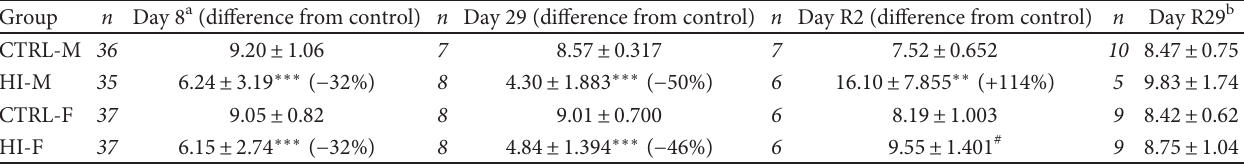
Table 4: Single time-point plasma glucose level (mM), mean ±